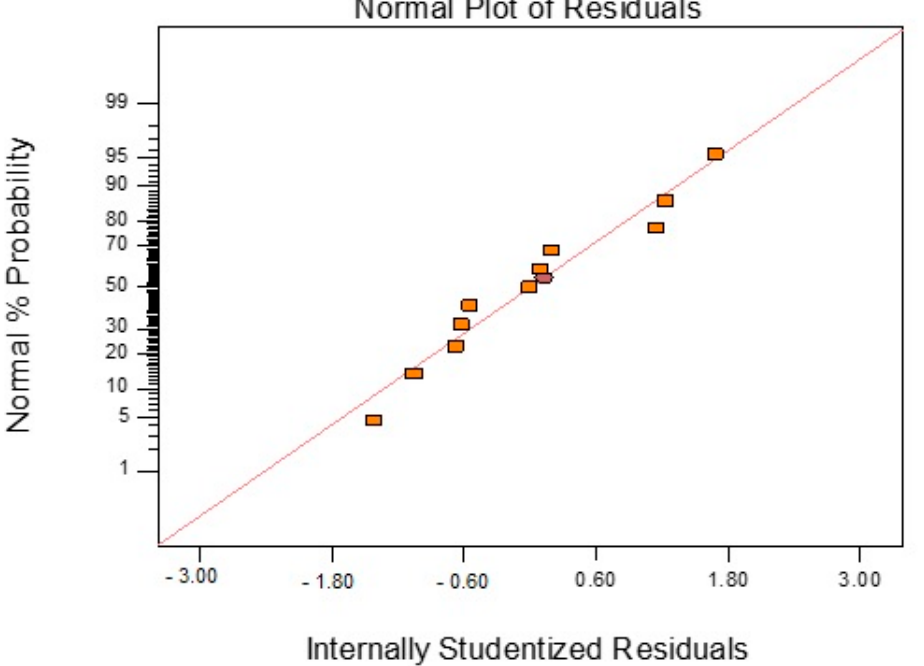
Figure 14. Normal probability plot of residual of PW data (rectangular plots are the point in CCD).